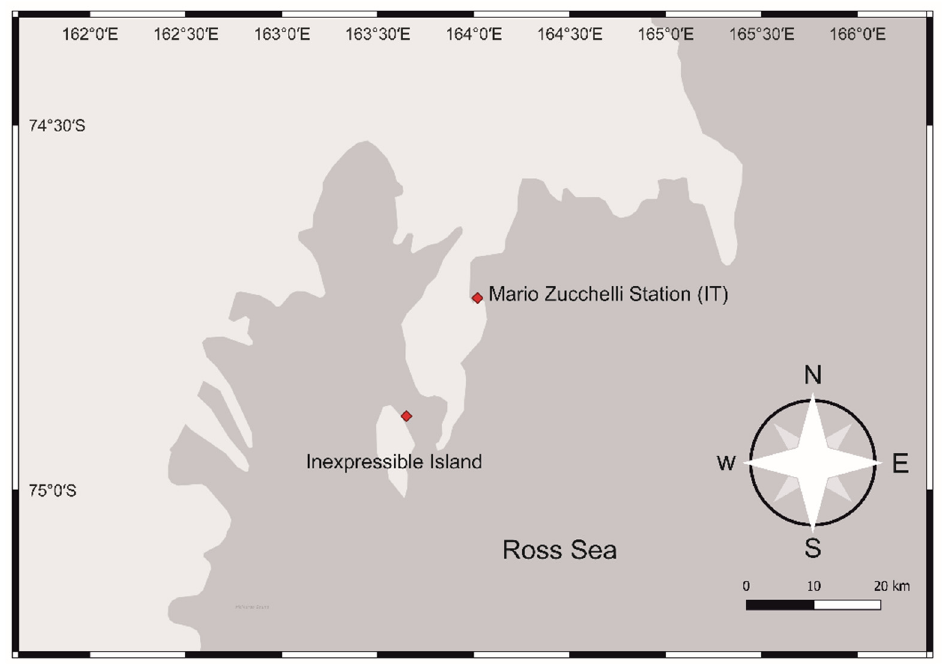
Figure 1. Map of the sampling sites, indicated by red diamonds.